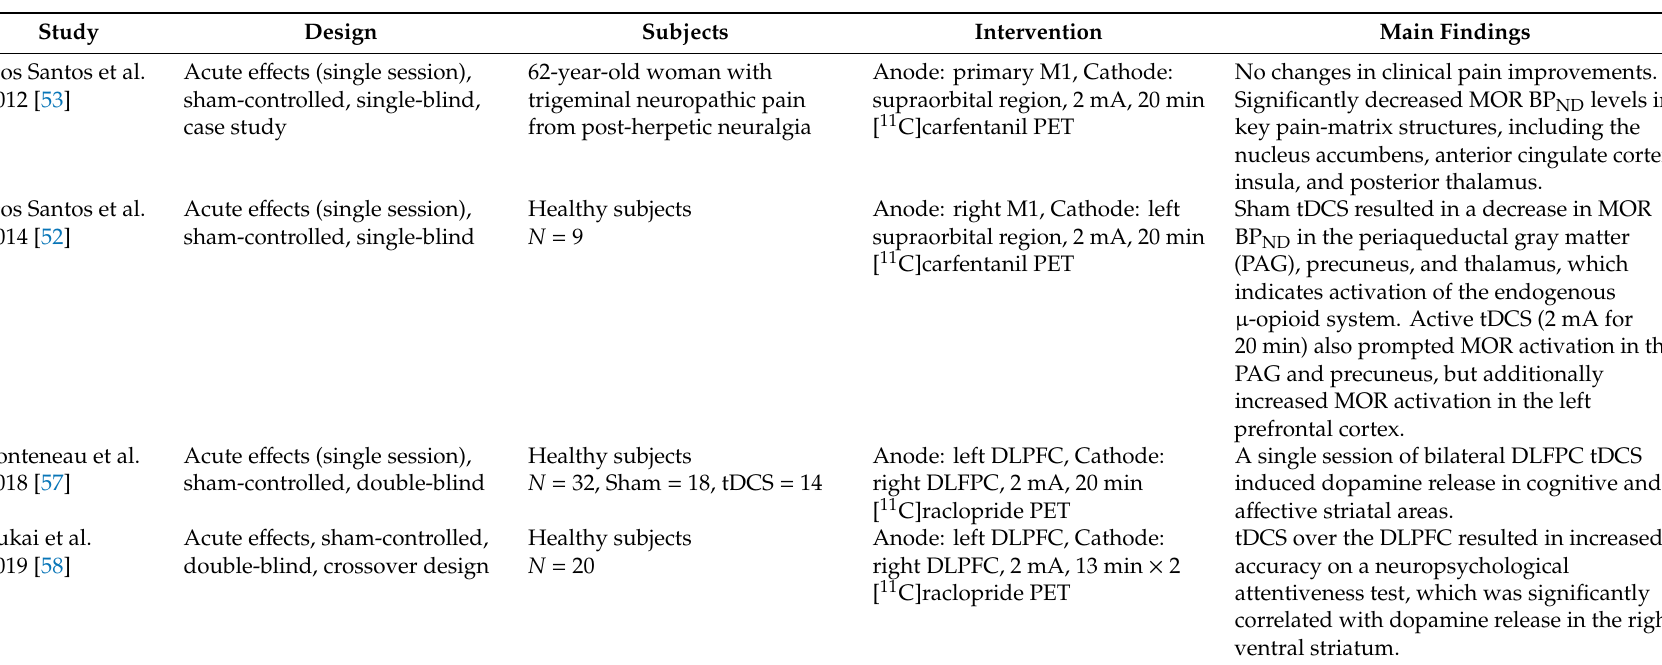
Table 3. Summary of studies that investigated the e ff ects of transcranial direct current stimulation (tDCS) with [11C]carfentanil and [11C]raclopride PET. Study